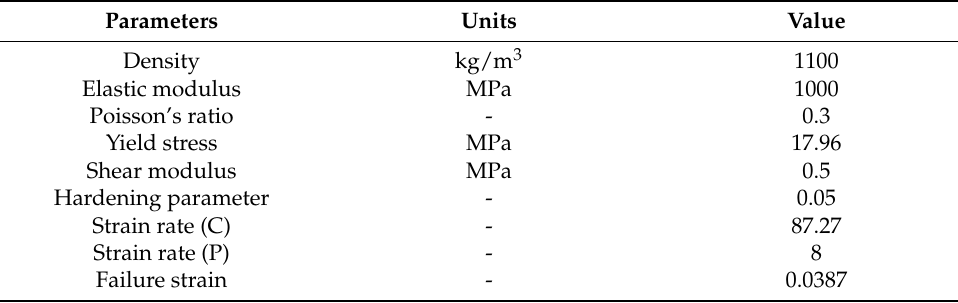
Table 2. Stem parameter settings of the wild chrysanthemum.